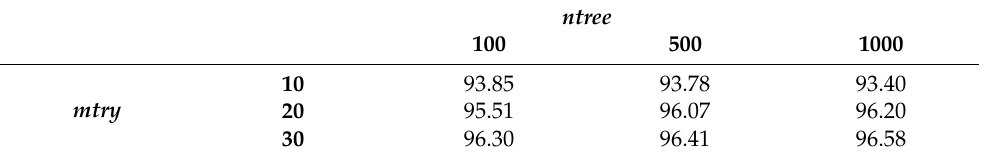
Table 5. The cross-validated grid search relationship between the overall accuracy (%) and hyperpa- rameters ( mtry and ntree ) of the RF